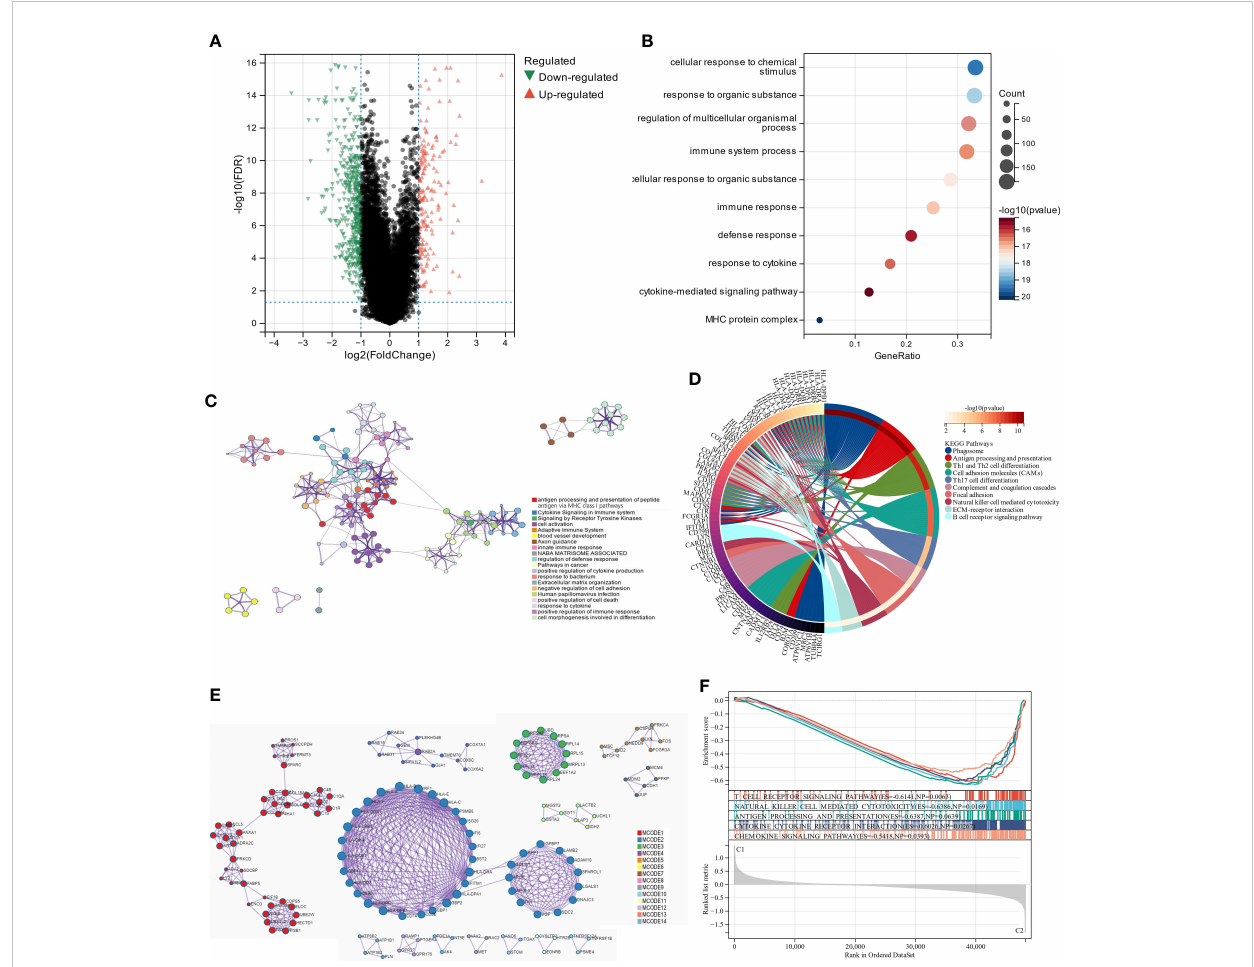
FIGURE 3 The analysis of differentially expressed genes and the evaluation of their functions. (A) Volcano plot illustrates the expression of DEGs between the two subgroups. (B, C) Visualization of biological processes that have been enhanced by GO analysis using bubble diagrams and networks. (D) A circle plot displaying the signaling pathways that KEGG analysis has enriched. (E) An analysis of DEGs based on PPI. (F) A GSEA plot depicts the signaling pathway